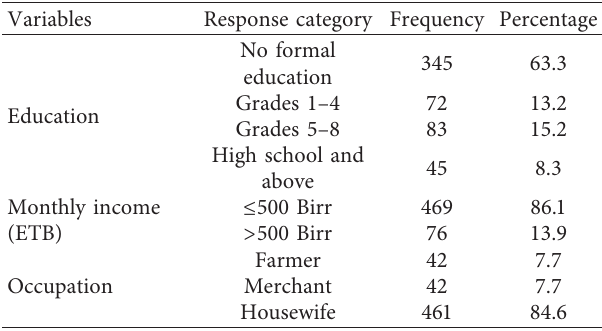
Table 1: Sociodemographic characteristics of households, in Boloso Sore woreda, Wolaita zone, Ethiopia, January 2019 ( n �